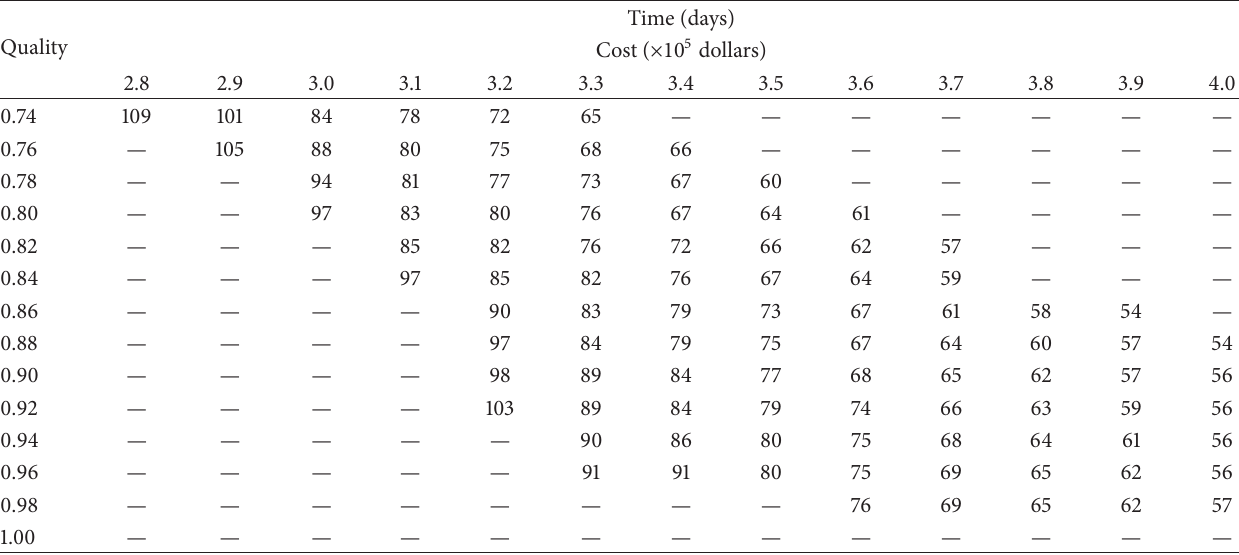
Table 3: The minimum time of a building project while project cost and general quality are